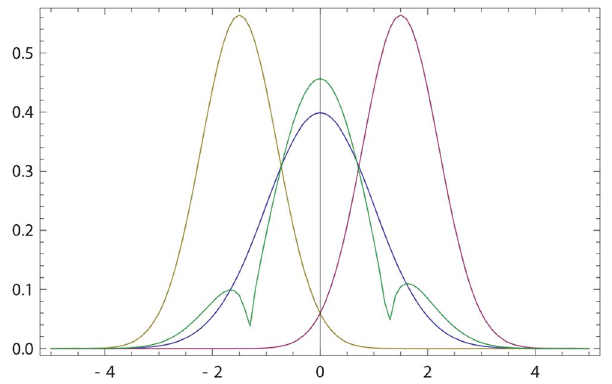
Figure 8. Illustration of the order of presentation effect in the g ( E ) given by (50, 51) versus E boomerang regime. p 1 ( q , q ’ ) ~ g ( E ) z 1